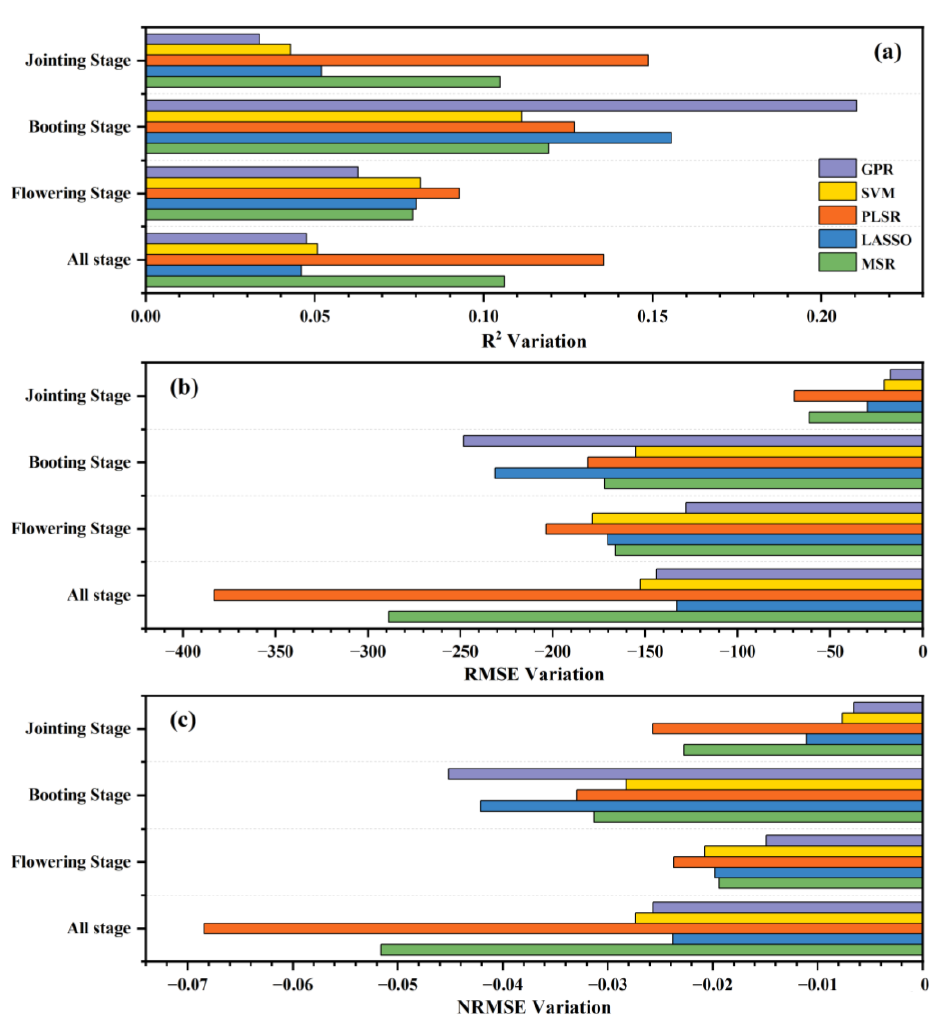
Figure 9. Comparison of ( a ) R 2 variation, ( b ) RMSE variation and ( c ) NRMSE variation between estimation model with CIS and estimation model with CIS + PH.